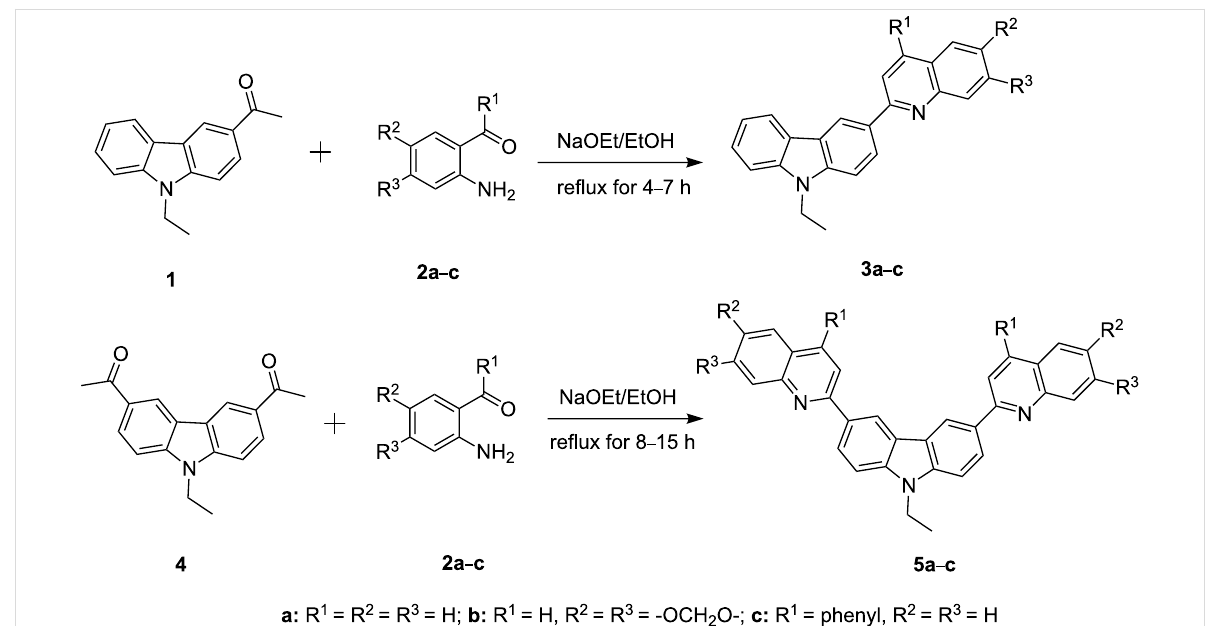
Scheme 1: Synthetic route of the title compounds 3a–5c